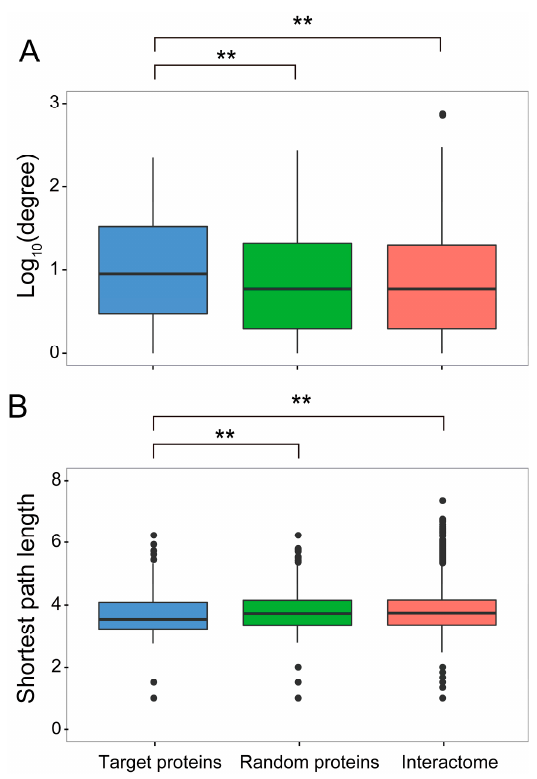
Figure 3. Global topological properties of the network. ( A ) Degree. ( B ) Shortest path length. These properties were calculated based on the 436 Arabidopsis best hits of the N. benthamiana interactors of the TYLCV proteins, termed target proteins, in the global Arabidopsis protein-protein interaction network. By comparison with control sets, both topology properties are significantly different between the Arabidopsis best hits and control sets (Mann-Whitney test; ** p -value < 0.01). A set of 200 randomly selected proteins, termed “random proteins” in the Arabidopsis interactome, as well as the whole interactome, were used as controls. The average degree exponent of target proteins was 0.964, while it was 0.838 in a random sample, and 0.837 in the whole network. The average shortest path of target proteins was 3.69, while it was 3.77 in a random sample and 3.80 in the whole network.